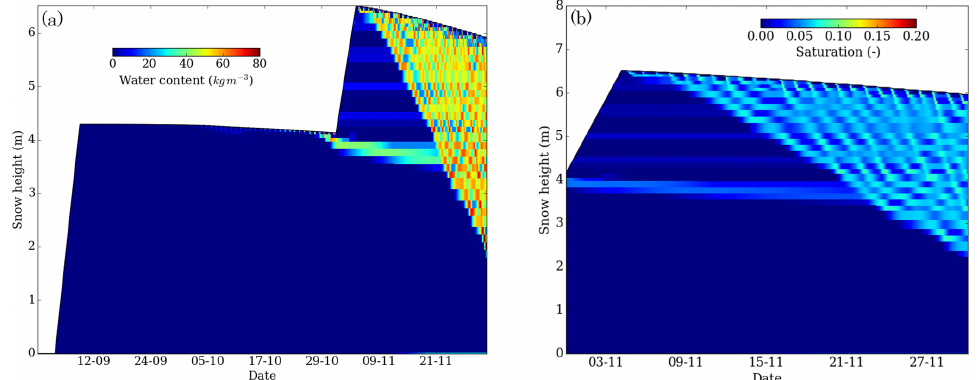
Figure 10. Crocus output for simulated forcing with SNOWCROMETAMO (snow metamorphism routine) and SNOWCROCOMPACT (snow compaction routine) turned off. The time step t was restricted to maximum of 30s for numerical stability. Panel (a) shows water content (kgm − 3 ) and (b) is the saturation (unitless); these plots show that without feedback the Richards routine percolates water down the snowpack with maximum LWC <